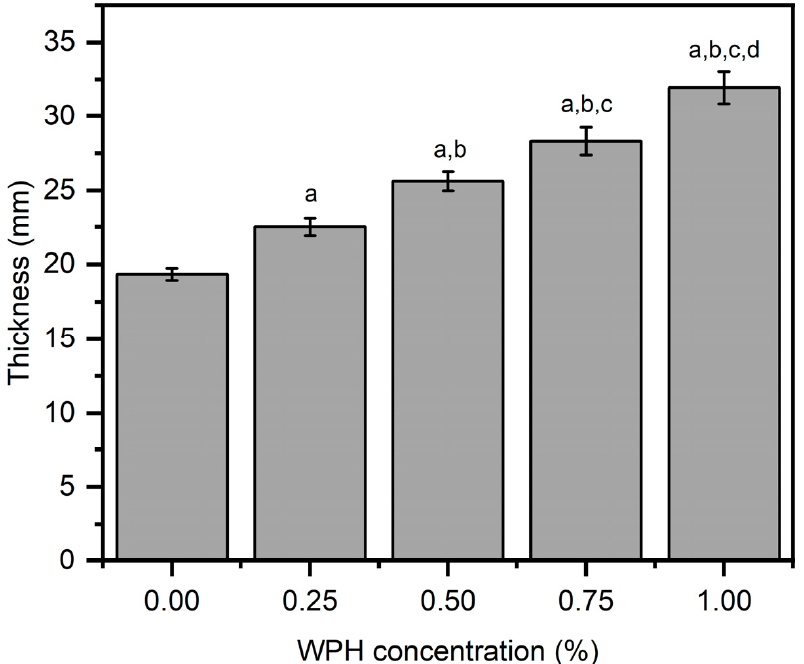
Figure 1. The thickness properties of chitosan/WPH films containing different concentrations of WPH. Data are presented as an average of three measurements ± standard deviation. Values with different letters on the top of bars are significantly different ( p < 0.05) and determined by using a Bonferroni post hoc test in a one way ANOVA analysis—a, b, c, d are relative to films comprising 0 wt%, 0.25 wt%, 0.5 wt% and 0.75 wt% WPH,